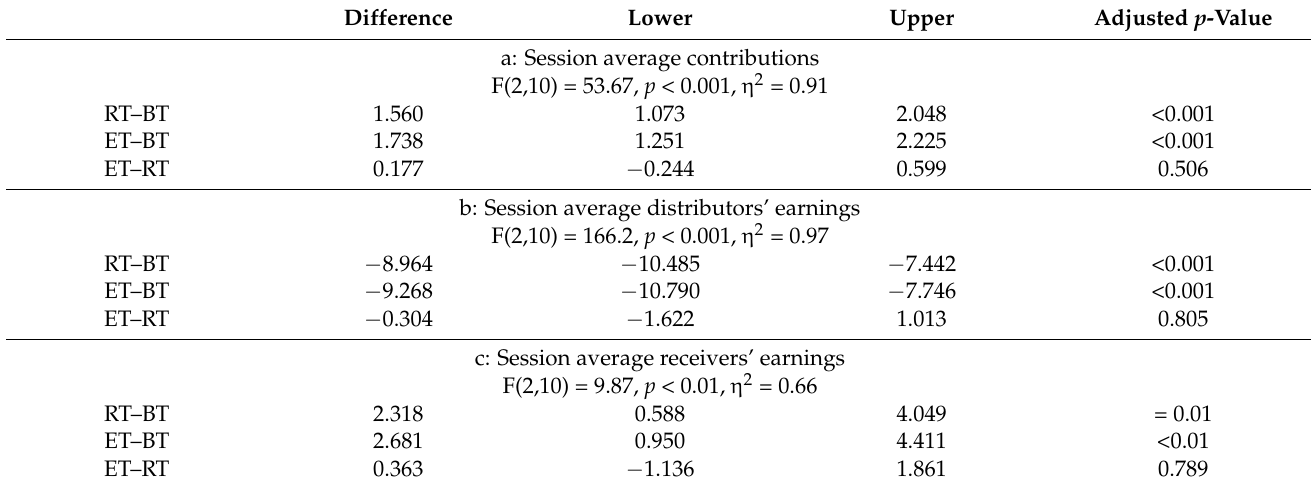
Table 2. Values for the 95% family-wise confidence level, Tukey’s “Honest Significant Difference” method.